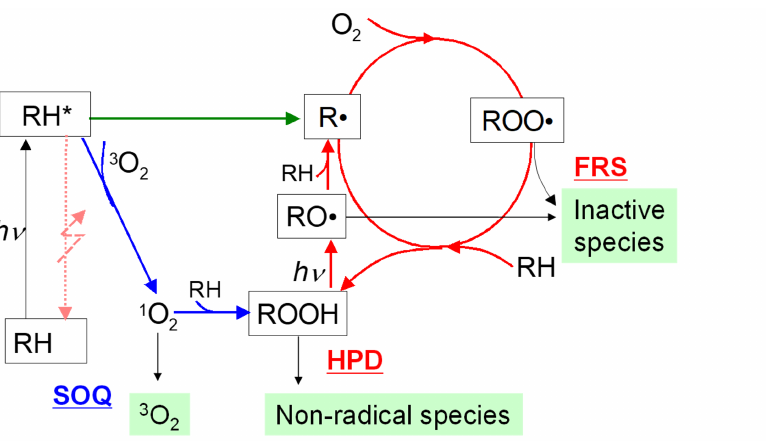
Figure 2. Schematic of photostabilization by